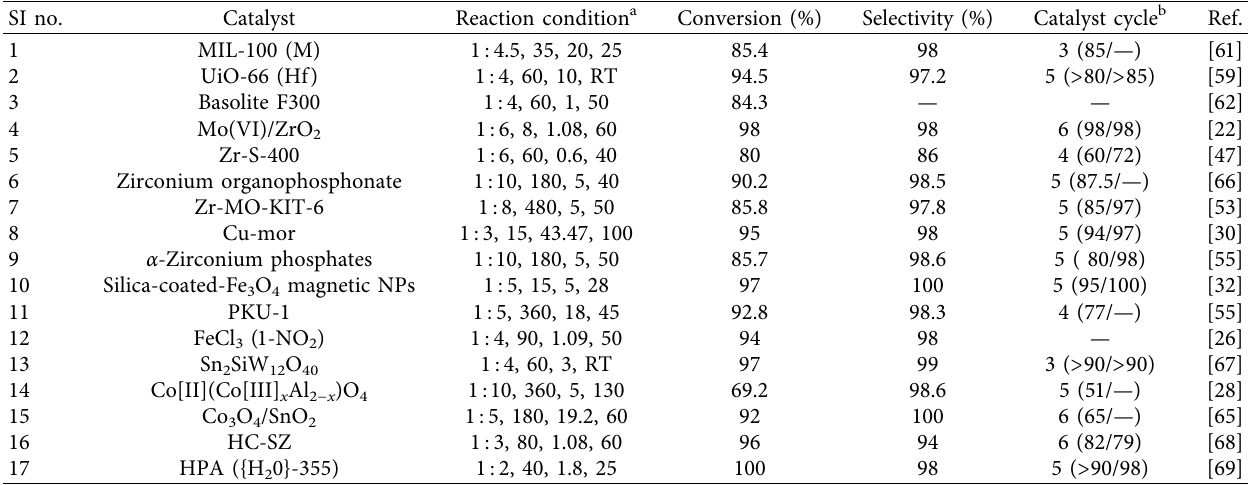
Table 1: Metal-based catalyst for solketal